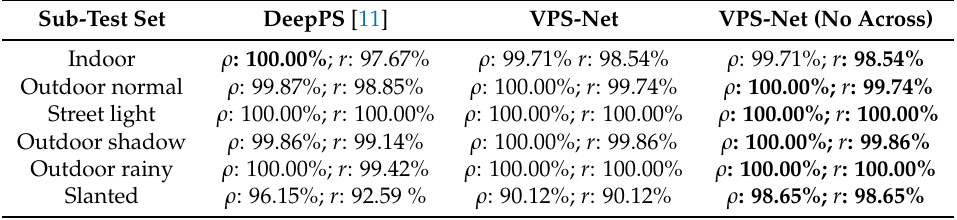
Figure 13. ( a , b ) show representative images in the ps2.0 test dataset where the vehicle is across parking slots. Table 5. Parking slot detection performance of different methods in the ps2.0 sub-test sets.